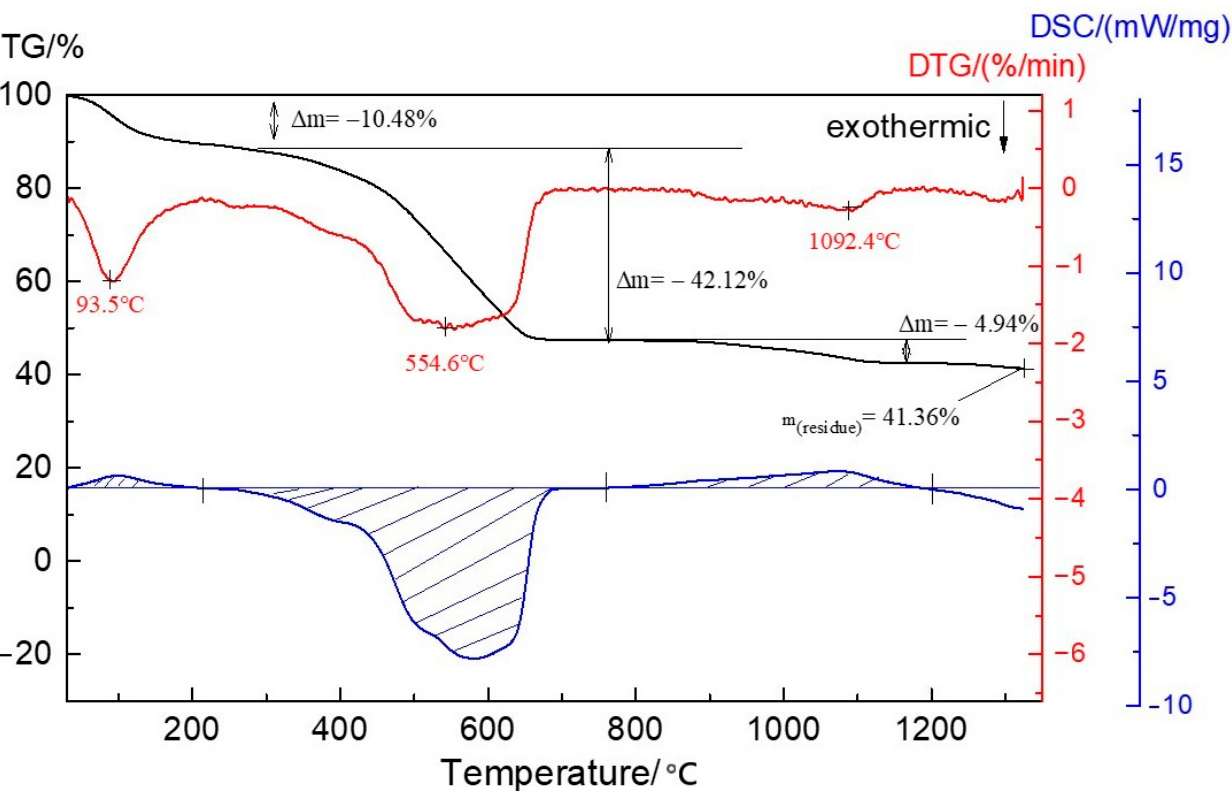
Figure 1. The HA binder DTG curve showed three distinct mass loss peaks during the roasting process, with a total HA binder mass loss of 58.64%. Correspondingly, two en- cess, with a total HA binder mass loss of 58.64%. Correspondingly, two endothermic peaks dothermic peaks and one exothermic peak appeared in the DSC curve. First, an endother- mic peak appeared at 93.5 °C due to the dehydration of the HA binder’s crystallized water, at 93.5 ◦ C due to the dehydration of the HA binder’s crystallized water, representing a representing a mass loss of 10.48%. When the temperature was increased from 200 °C to mass loss of 10.48%. When the temperature was increased from 200 ◦ C to 700 ◦ C, a rapid 700 °C, a rapid mass loss of 42.12% occurred, as shown by the significantly exothermic mass loss of 42.12% occurred, as shown by the significantly exothermic peaks. This was peaks. This was due to the decomposition and depolymerization of the organic structure due to the decomposition and depolymerization of the organic structure as well as the as well as the combustion of carbon. Furthermore, a mass loss peak at 1092.4 °C, repre- combustion of carbon. Furthermore, a mass loss peak at 1092.4 ◦ C, representing a mass senting a mass loss of 4.94%, was attributed to condensation polymerization. loss of 4.94%, was attributed to condensation polymerization.